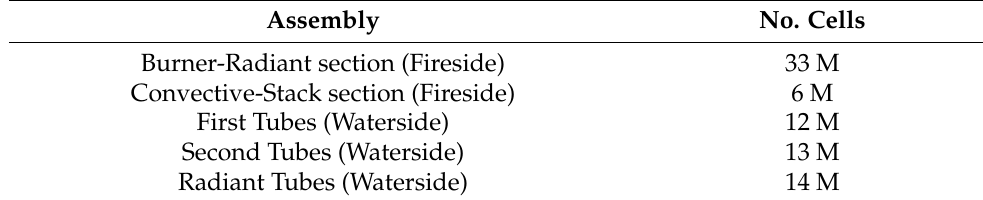
Table 9. Mesh statistics.